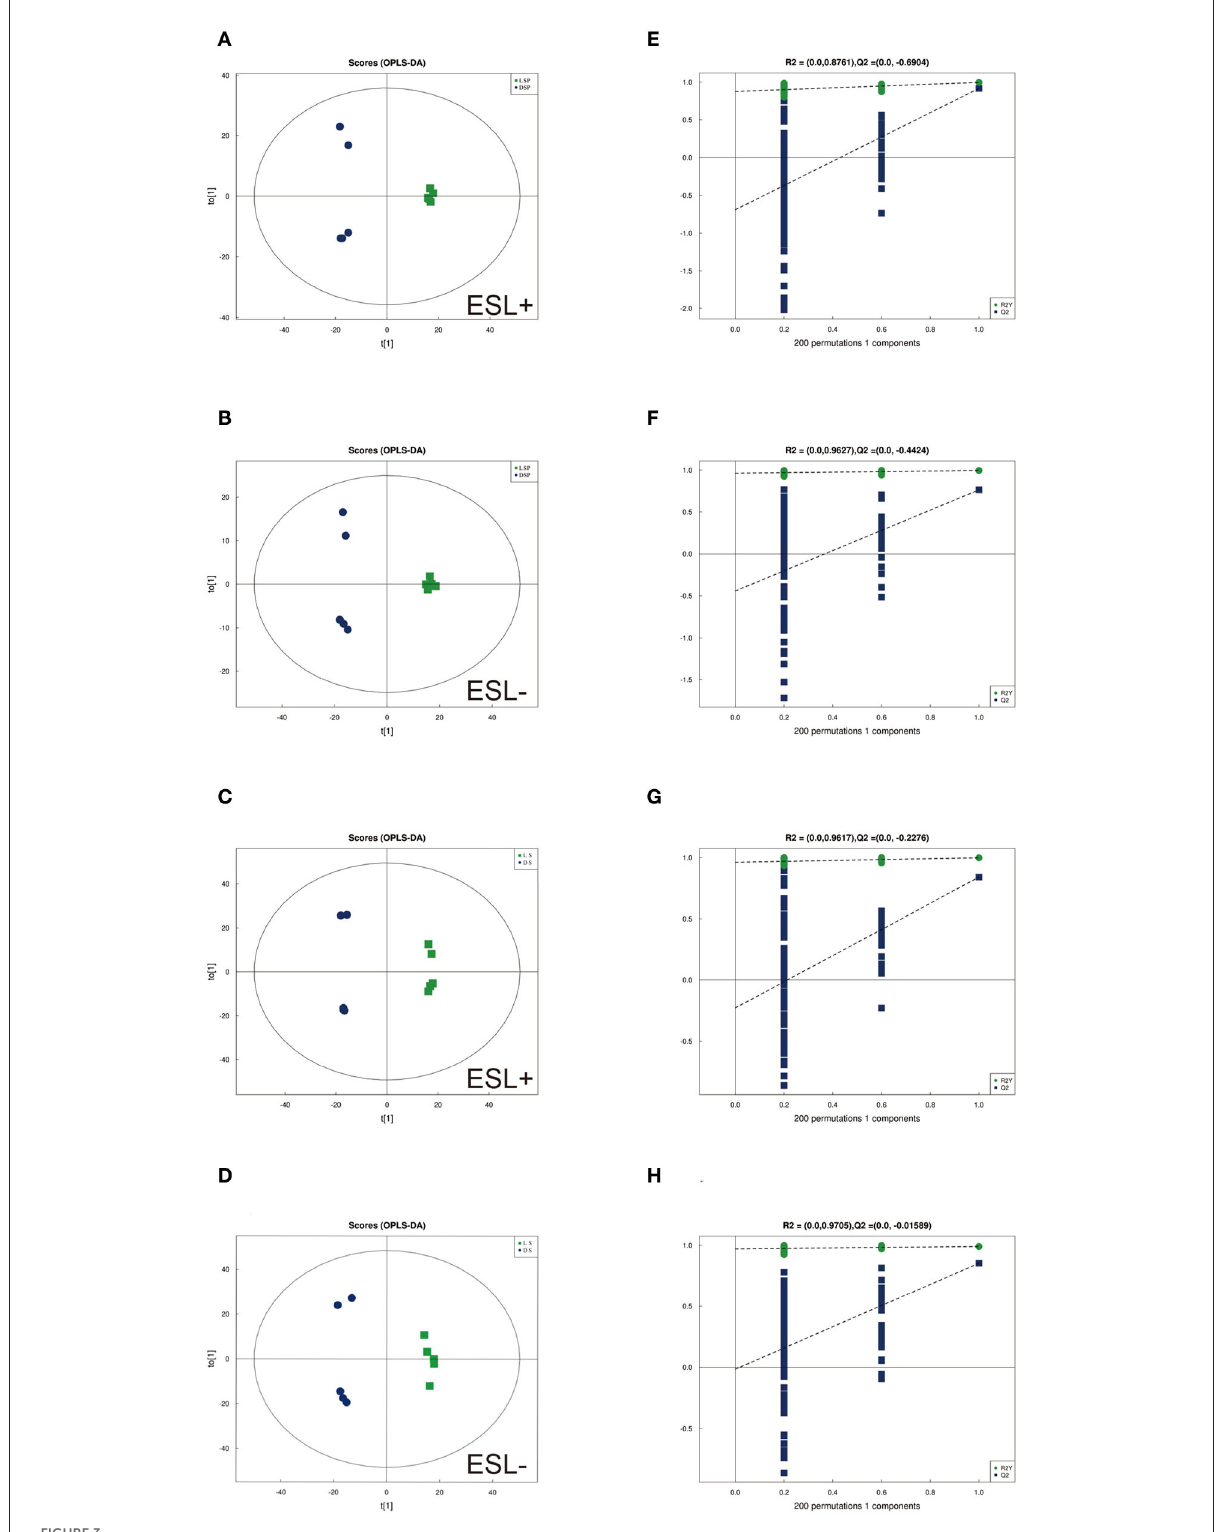
FIGURE3 OPLS-DA scores plots based on sperm and seminal plasma samples showing the correlations between the DSP, LSP, DS and LS group in both positive and negative modes ( n = 5 per group). (A, B) Seminal plasma scores plots of (A) R2y = 99%, Q2 = 0.92 (positive). (B) R2y = 99%, Q2 = 0.76 (negative). (C, D) Sperm scores plots of (C) R2y = 99%, Q2 = 0.84 (positive). (D) R2y = 99%, Q2 = 0.85 (negative). (E–H) Corresponding statistical validation of OPLS-DA models by permutation